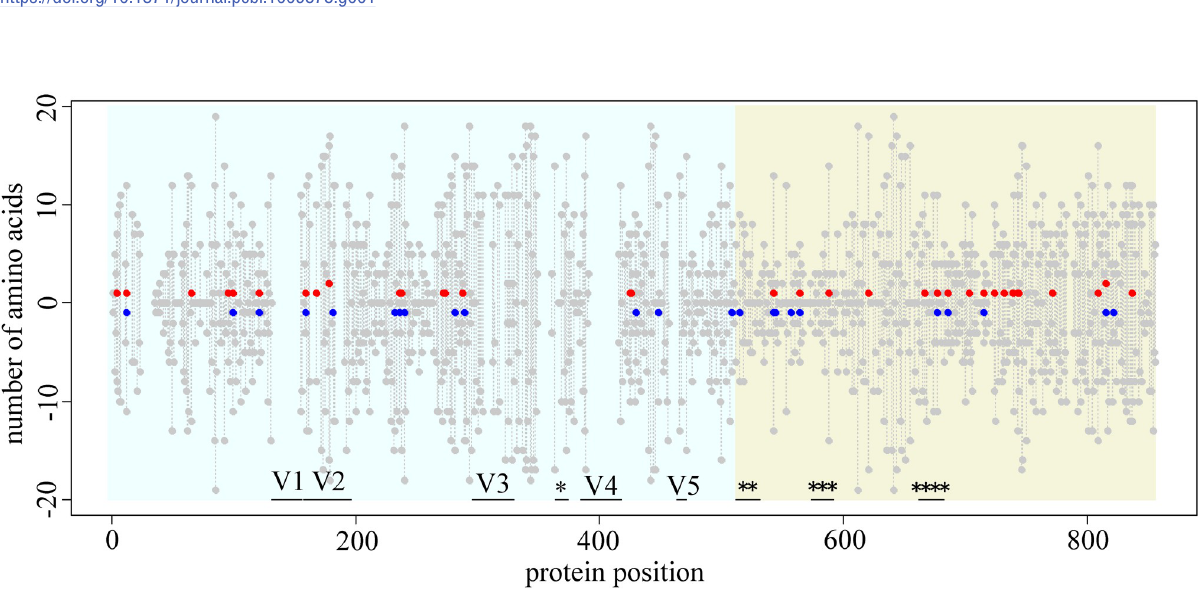
Fig 2. Amino acid sites carrying variable fitness amino acids in gp160 protein of HIV-1. For each position of the amino acid within the protein (horizontal axis), the red dot shows the number of amino acids that are simultaneously proximal to the BF520 strain and distal from the LAI strain; and the blue dot, the number of amino acids that are simultaneously proximal to the LAI strain and distal from the BF520 strain, multiplied by -1. Grey dots represent the number of testable amino acids (see Materials and methods). The positions without any dots are sites filtered out due to alignment ambiguity. Vertical grey lines connect dots for the same site. Blue background, gp120; green background, gp41. Variable loops V1-V5 and known functional domains are marked by horizontal black lines: � , CD4-binding loop; �� , fusion peptide; ��� , immunosuppressive region; ���� , membrane proximal external region (MPER). Numbering of protein positions is hxb2-based.